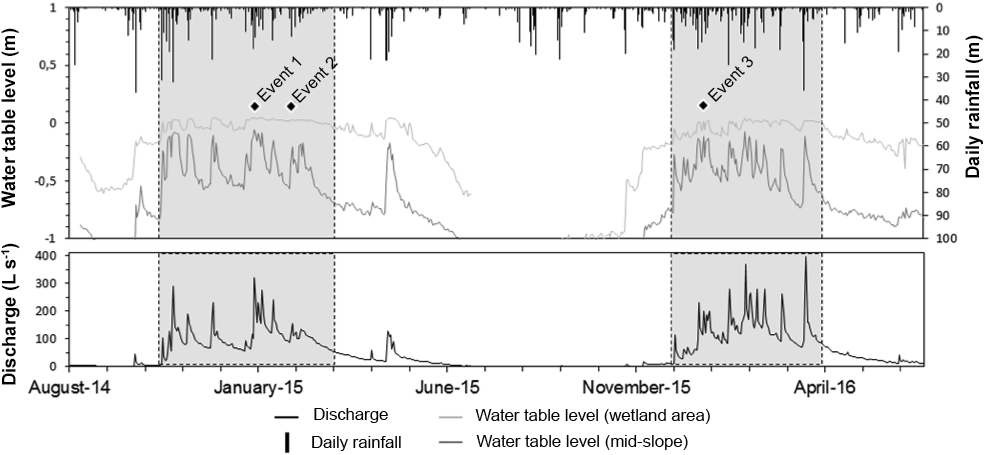
Figure 2. Daily rainfall, water table level and discharge during hydrological years 2014–2015 and 2015–2016. The storm events were sampled when water table remains in surface horizons in the wetland area (hydrological period B – grey areas). This period is characterized by hydrological connectivity between mid-slope and wetland soils during rain